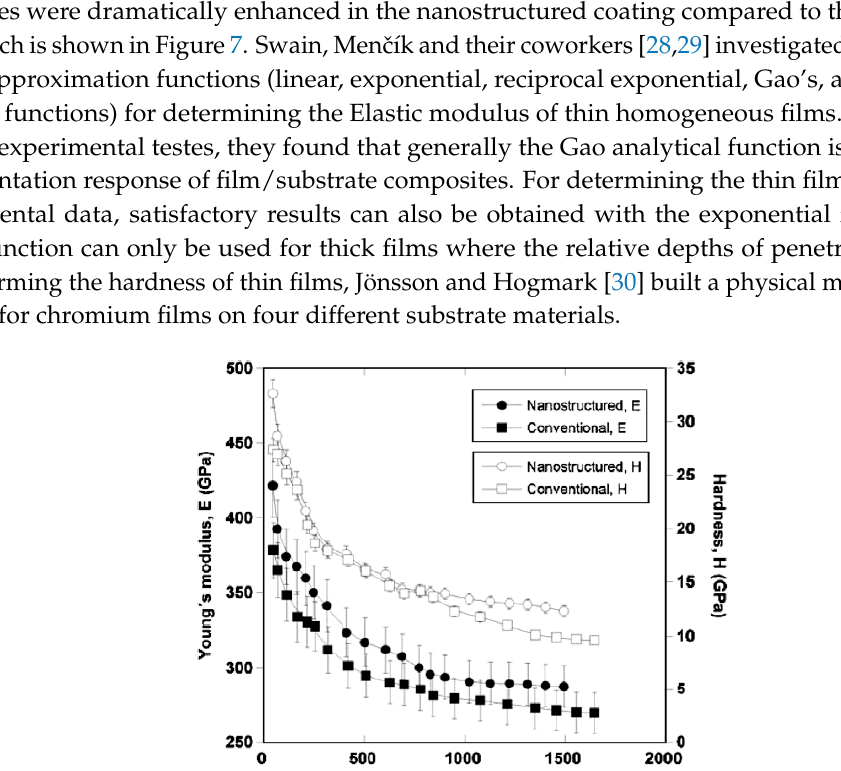
Figure 8. Top view of the double ring sample [32]. Indentation tests were also used to evaluate adhesion strength of the thermal barrier coatings (TBCs) which were used to improve the performance and efficiency of advanced gas turbines [34–38].